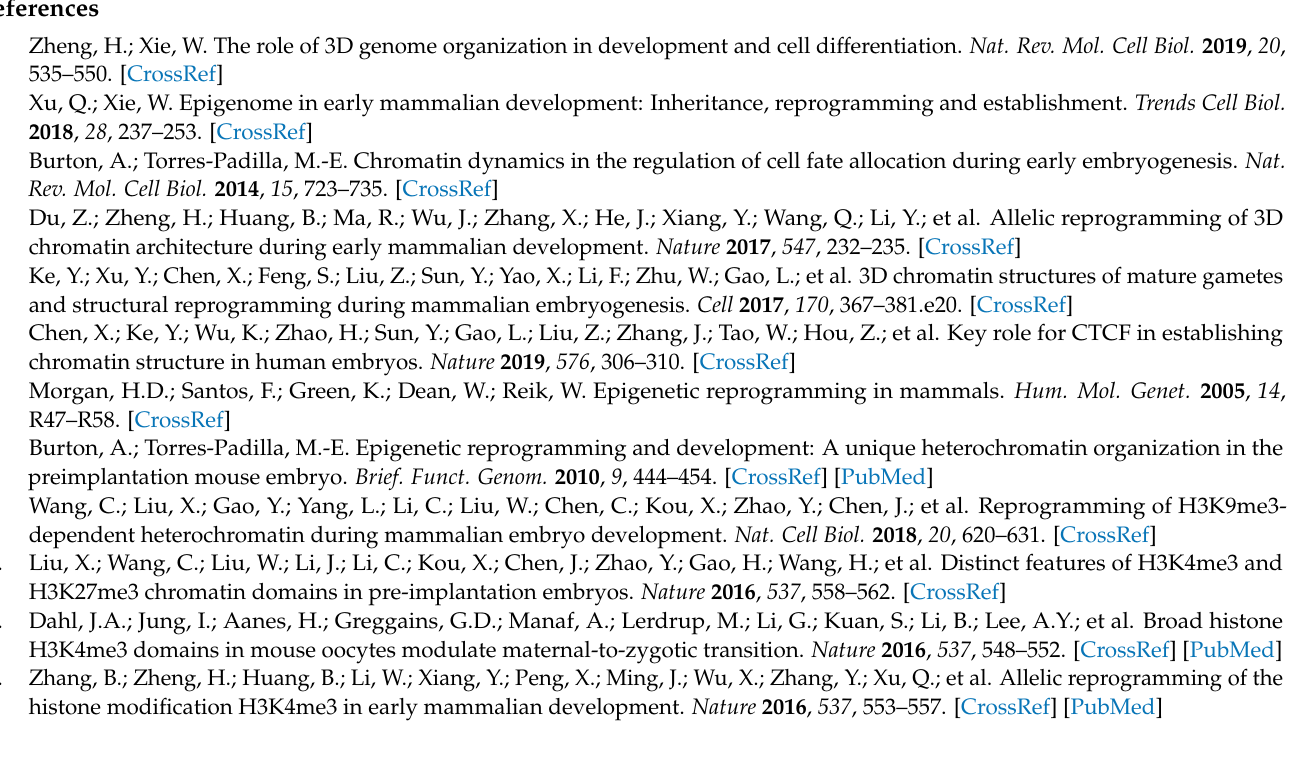
Figure S1: Domain segregation in early embryonic development, Figure S2: Comparisons between maternal and paternal genomes, Figure S3: Compartment changes related to domain segregation, Figure S4: Domain segregation and differentiated DNA methylation associated with germ layer formation, Figure S5: Implantation-related domain mixing in differentiation, Figure S6: Chromatin structural patterns at different stages, Figure S7: The association between transcription inhibition and genome architecture), Additional file 2: